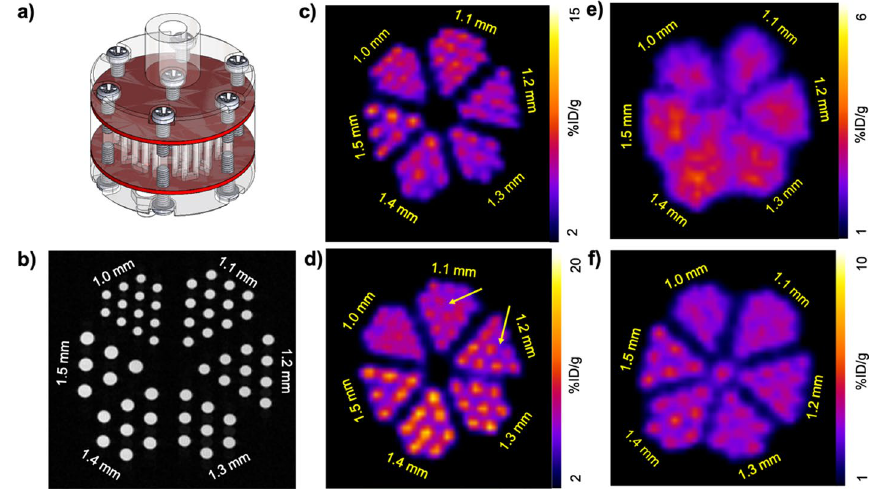
Fig. 3 PET spatial resolution in the presence of the MRI instrument. a A schematic of the Derenzo phantom (image reproduced with permission from Phantech Medical). b MR image of the phantom. c The phantom with ~ 3.7 MBq (100 µCi) of fluorine-18 was placed at axial center in the PET insert. A spatial resolution of 1.0 mm was achievable. d The phantom of fluorine-18 and the PET insert were moved inside the MRI instrument. A spatial resolution of 1.0 mm was still achievable along with sharpening of the channels in some sections (yellow arrows). e The phantom with ~ 3.7 MBq (100 µCi) of gallium-68 was placed at axial center in the PET insert. The spatial resolution was greater than 1.5 mm. f The phantom with gallium-68 and the PET insert were moved inside the MRI instrument, and a spatial resolution of 1.2 mm was